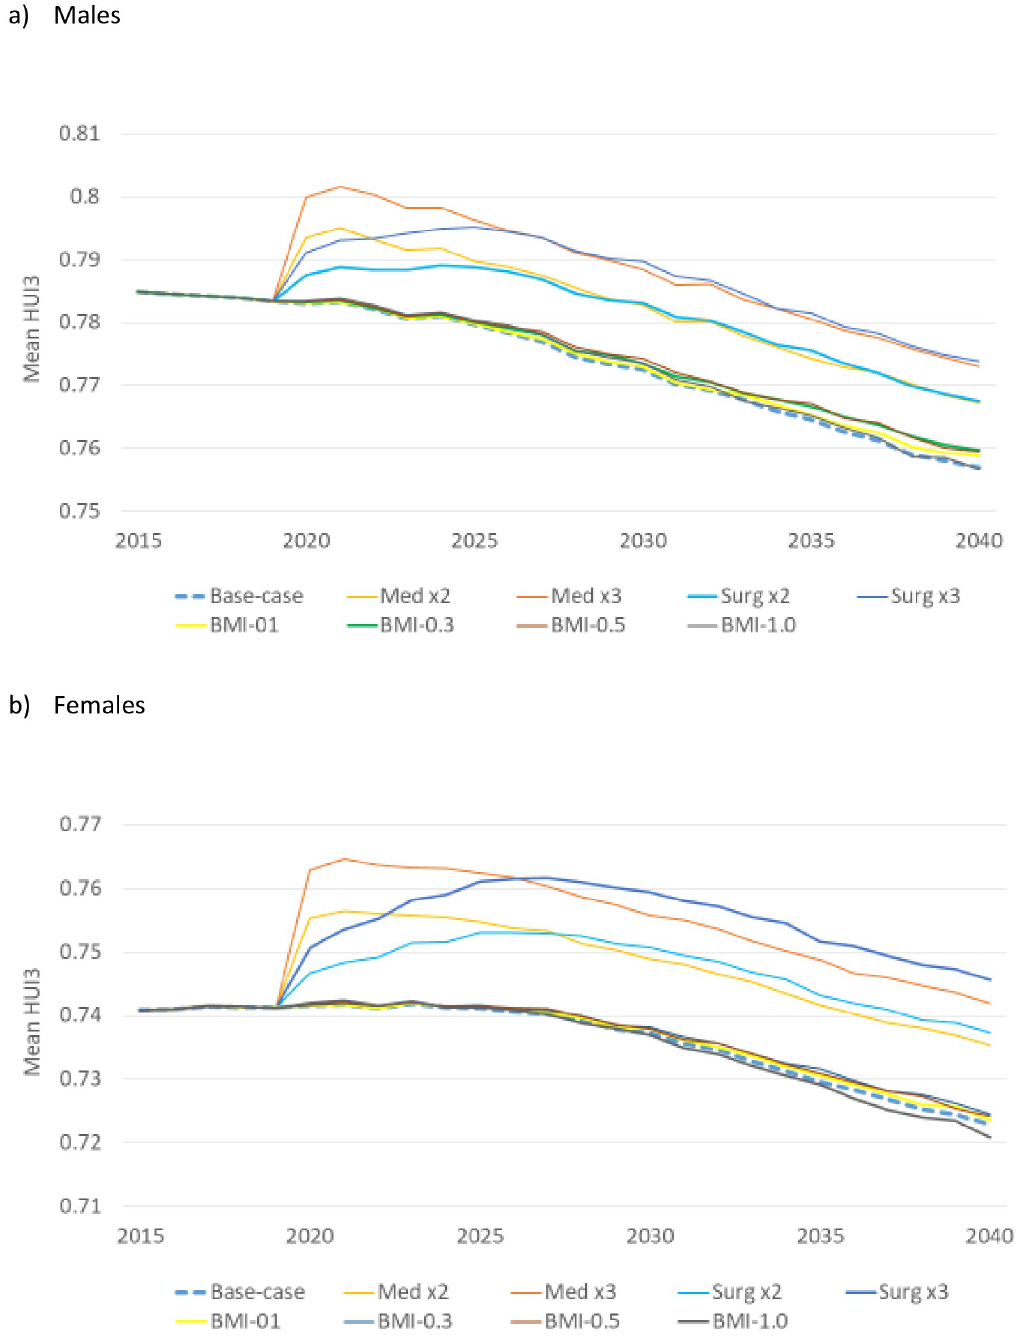
Fig 4. Mean HUI3 among persons with osteoarthritis before and after each intervention. HUI3, Health Utilities Index Mark 3. All interventions are described in Table 1. The trend in HUI3 may appear steep because the Y-axis range was restricted to better visualize the impact of